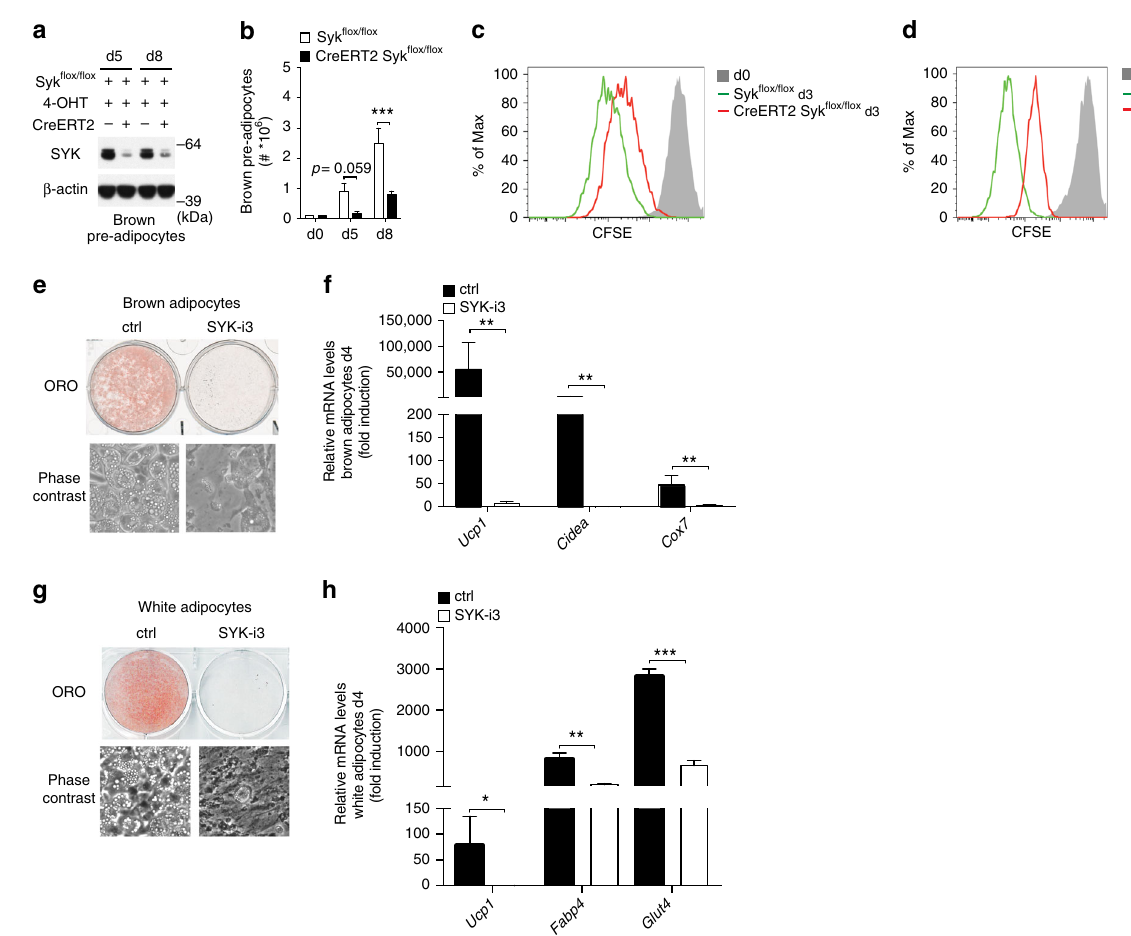
Fig. 3 SYK is essential for pre-adipocyte proliferation and for adipocyte differentiation. Representative western blot of SYK protein expression ( a ), cell numbers of three independent experiments ( b ) and representative fl ow cytometry of three independent experiments of CFSE staining analyzed by fl ow cytometry ( c ) of brown CreERT2 Syk fl ox/ fl ox and Syk fl ox/ fl ox pre-adipocytes seeded at equal cell numbers (d0) following continuous 4-hydroxy tamoxifen (4-OHT) treatment beginning 3 days prior. d Representative fl ow cytometry of three independent experiments of primary brown pre-adipocytes 3 days after labeling with CFSE and addition of 5 μ M Syk-i3. Oil red oil staining (ORO), phase contrast images, and mRNA expression 4 days post induction of differentiation of primary brown ( e , f ) and white ( g , h ) pre-adipocytes in the presence of 5 μ M SYK-i3 in the induction media; data are representative of three independent replicates. Mean cell number + SEM ( b ) and fold induction vs. d0 + SEM ( f , h ). For b , two-tailed unpaired Student ’ s t test was performed (* P < 0.05, ** P < 0.005 and *** P < 0.0005) and for f , h , two-tailed unpaired Student ’ s t test was performed on Log transformed